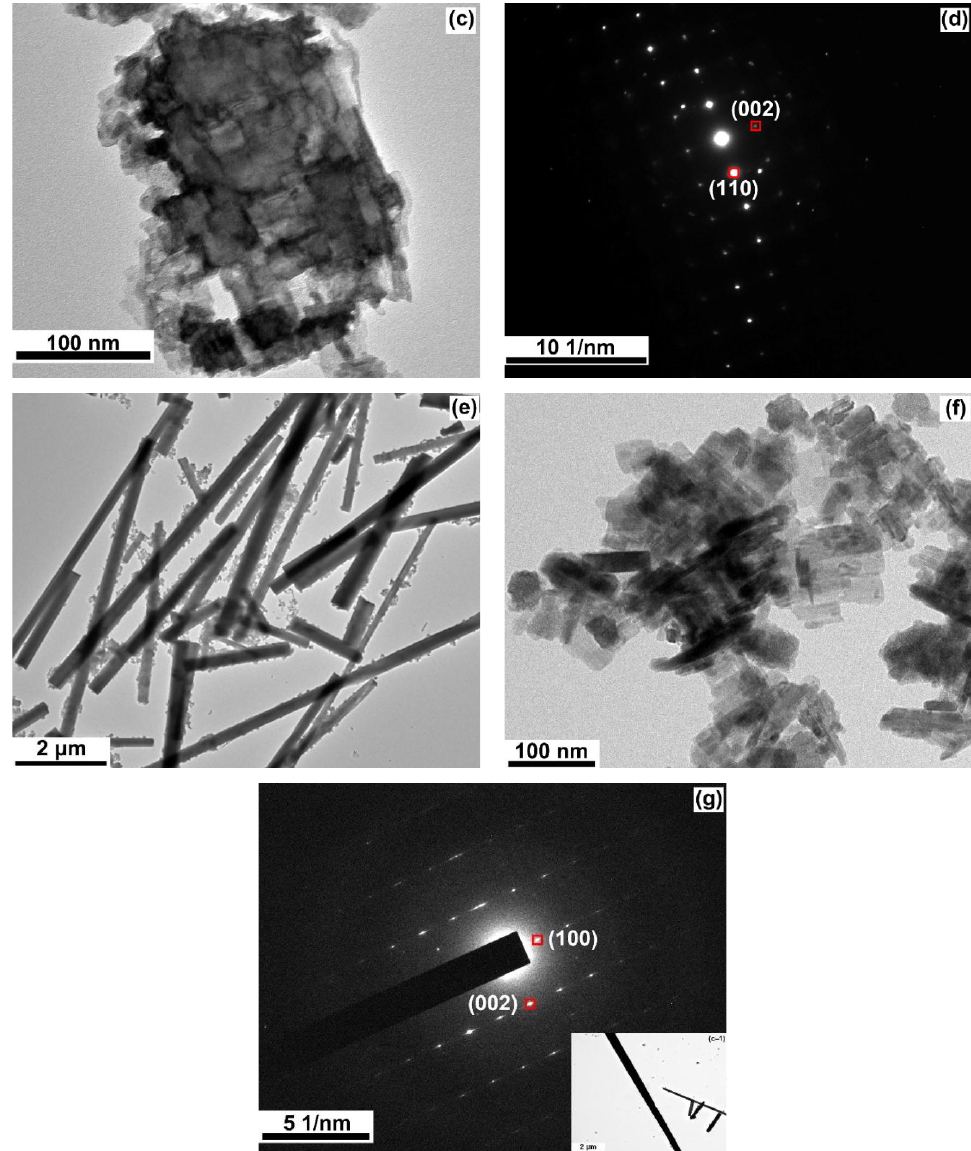
Figure 7. The TEM and SEAD images of samples synthesized hydrothermally at 200 °C using 0.18